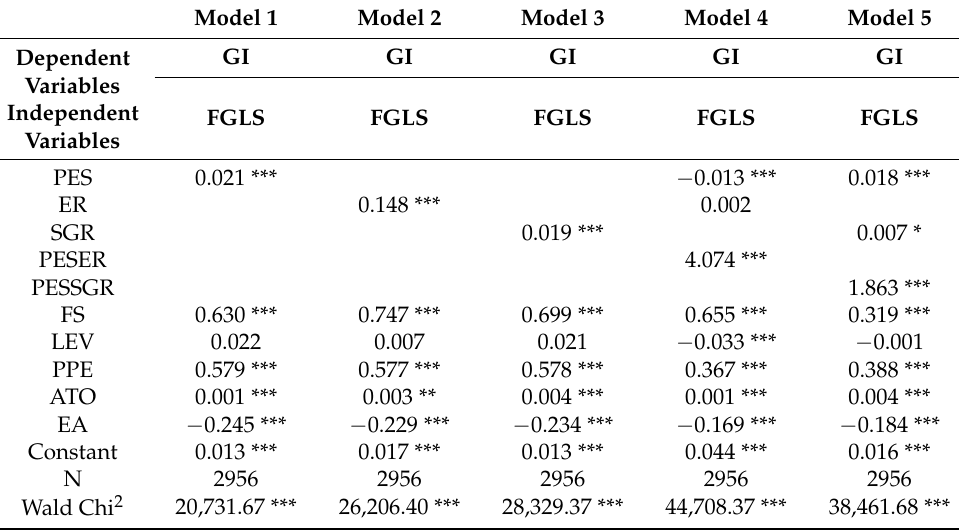
Table 5. The robustness results of feasible generalized least squares